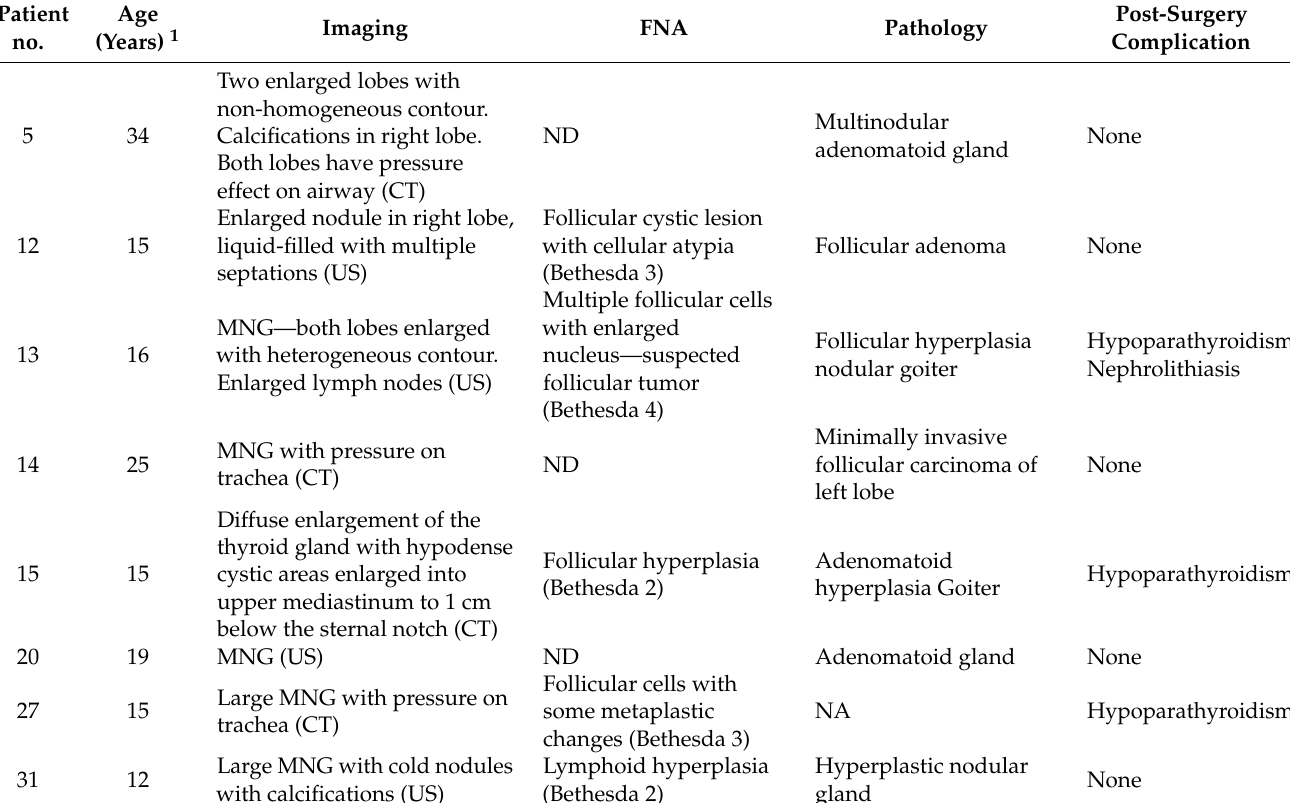
Table 3. Summary of imaging and pathology of patients that underwent thyroidectomy.